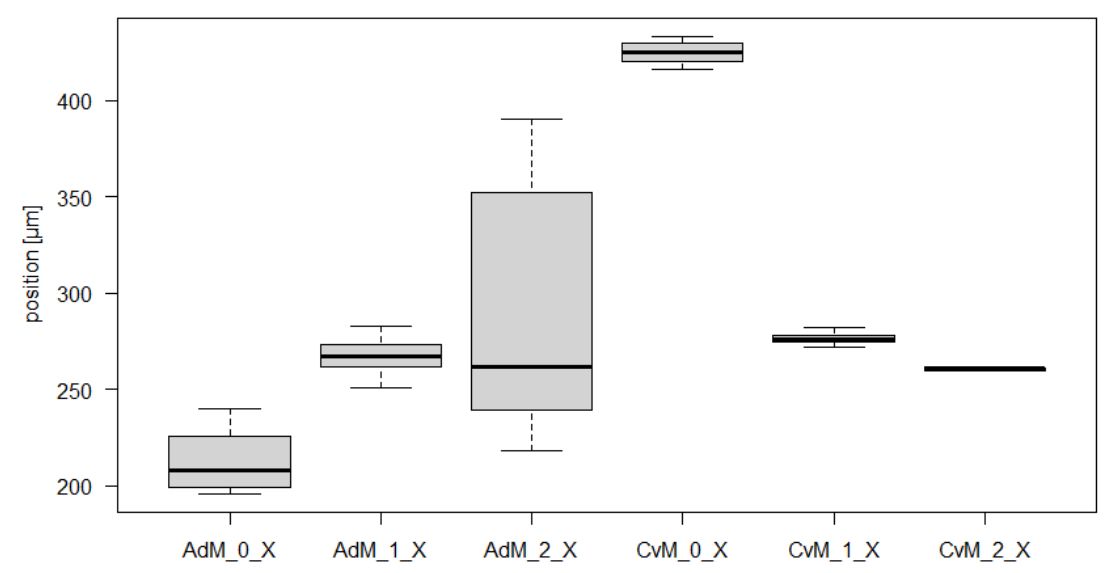
Figure 16. Measurements of NcM axis X.